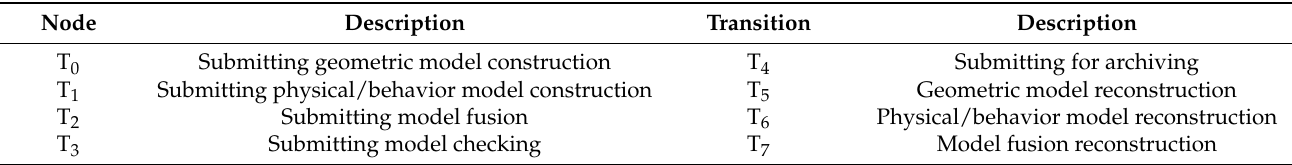
Table 2. Description of transitions in the